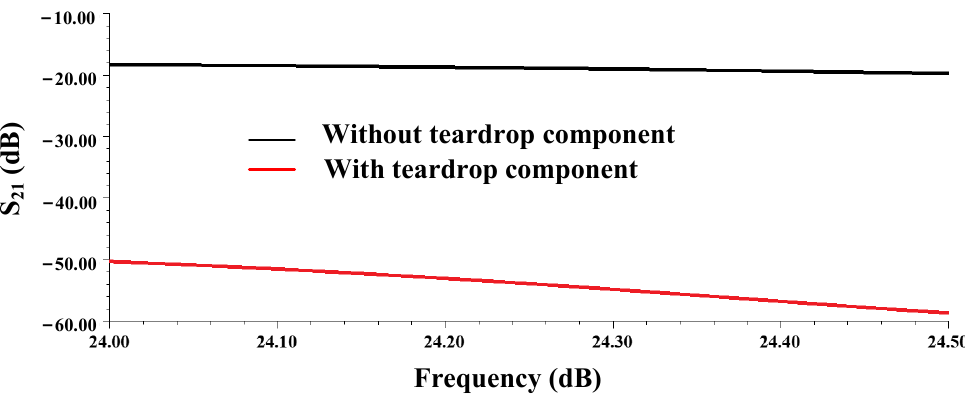
Figure 10. The simulated S 21 results of the cases with and without the teardrop-shaped component.